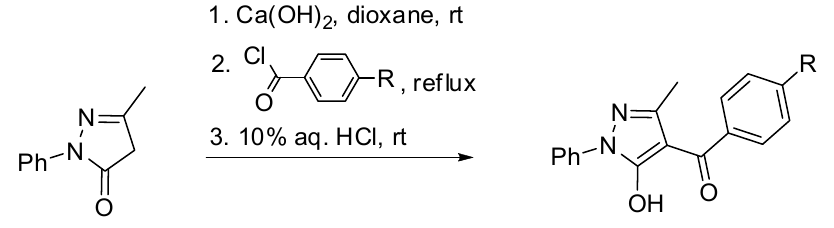
Figure 3. Selective C-acylation of 3-methyl-1-phenyl-pyrazol-5-one. The very low p K a value (1.23) makes 4-acyl-5-isoxazolones an interesting class of β -diketones for the extraction and separation of metal ions from strong acid media [59,60]; see Figure 3 in [53].